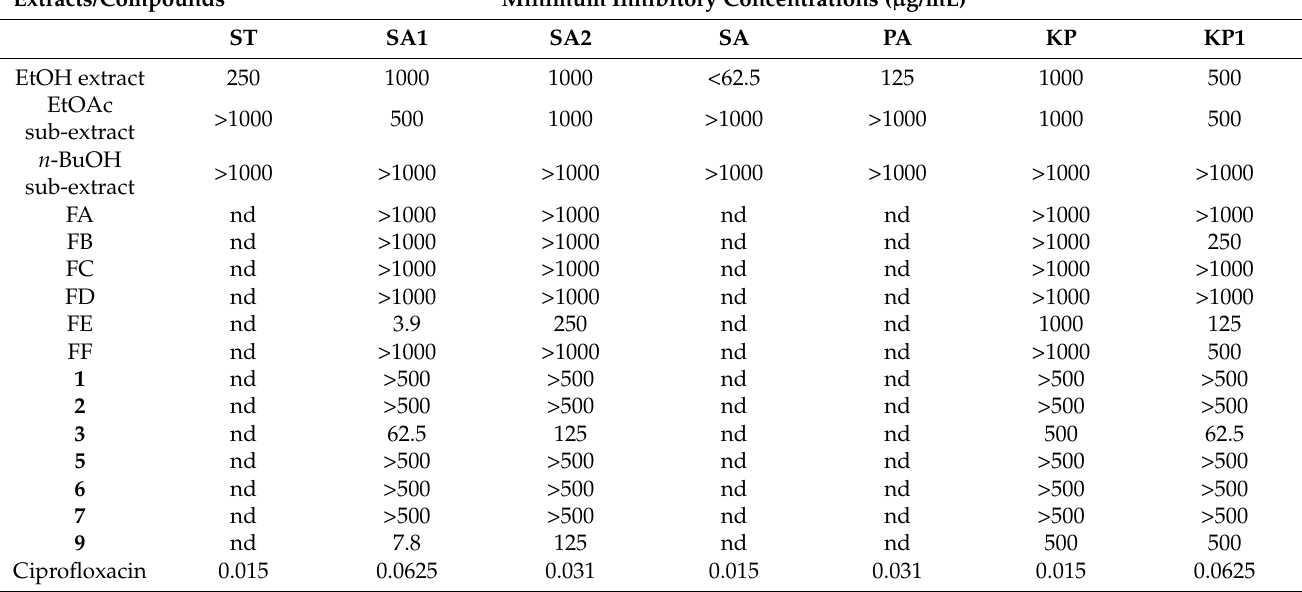
Table 2. Antibacterial activity of extracts, sub-extract, fractions, and some isolated compounds (MICs in µ